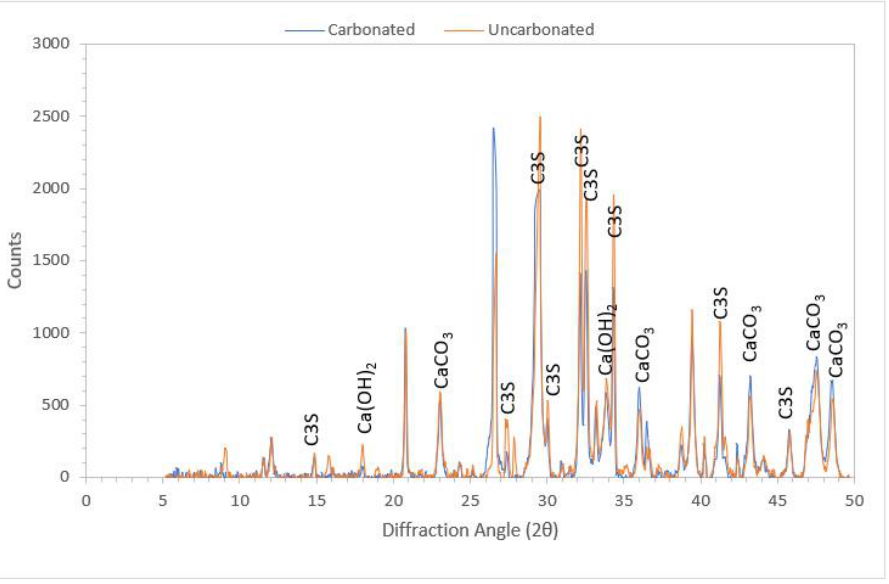
Figure 12. XRD showing tricalcium silicate (C 3 S), Ca(OH) 2 and CaCO 3 patterns in the carbonated and uncarbonated mortar samples. Carbonation took place at 2 bar for 24 h following 120 h of curing [28].